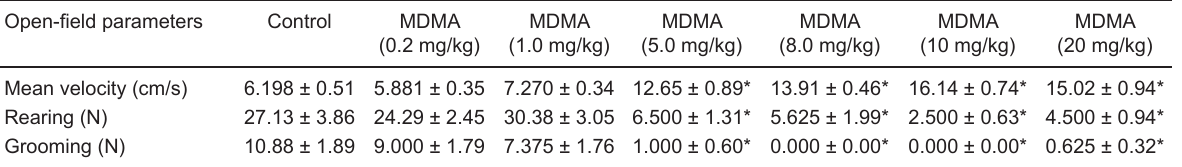
Table 1. Effects of 3,4-methylenedioxymethamphetamine (MDMA, 10 mg/kg) on BALB/c male mice in the open field 60 min after treatment. Open-field